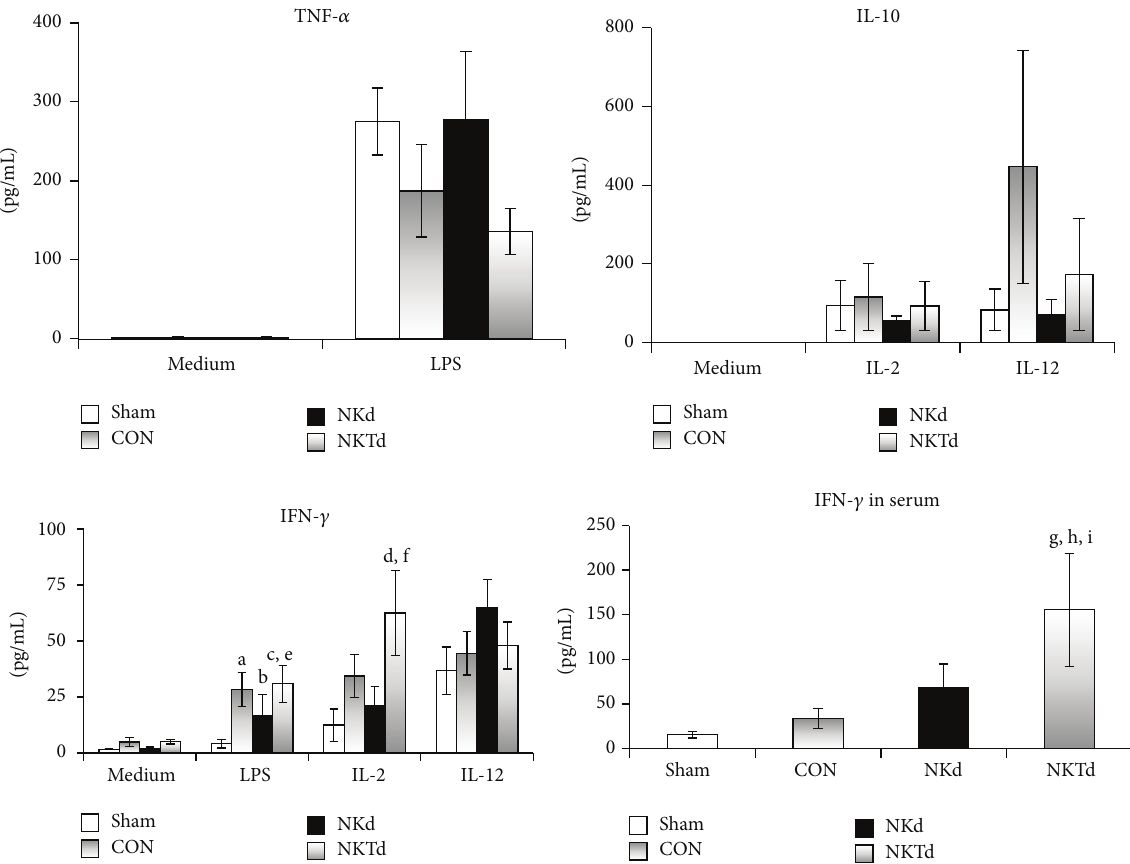
Figure 3: Cytokine production from splenocytes. Splenocytes were isolated after animal sacrifice 48 hours after bacterial challenge with Streptococcus pneumoniae . Mice were pretreated with nonspecific IgG (CON, 𝑛 = 13 ); with anti-asialo GM1 antibody (NKd, 𝑛 = 12 ); or with anti-CD1d antibody (NKTd, 𝑛 = 10 ). Results are compared with sham-operated mice (Sham, 𝑛 = 10 ). Concentrations of tumour necrosis factor-alpha (TNF- 𝛼 ), of interleukin (IL)-10 and of interferon-gamma (IFN- 𝛾 ) were measured in supernatants after stimulation with lipopolysaccharide (LPS) of Escherichia coli O55:B5, with IL-2 and with IL-12. Serum concentrations of IFN- 𝛾 at the time of animal sacrifice : 0.010; b 𝑝 : 0.033; are also shown. Statistically significant comparisons after corrections for multiple tests are indicated: a 𝑝 Sham VS CON Sham VS NKd c 𝑝 : 0.013; d 𝑝 : 0.049; e 𝑝 : 0.049; f 𝑝 : 0.037; g 𝑝 : 0.002; h 𝑝 : 0.009; i 𝑝 : Sham VS NKTd Sham VS NKTd NKd VS NKTd NKd VS NKTd Sham VS NKTd CON VS NKTd NKd VS NKTd